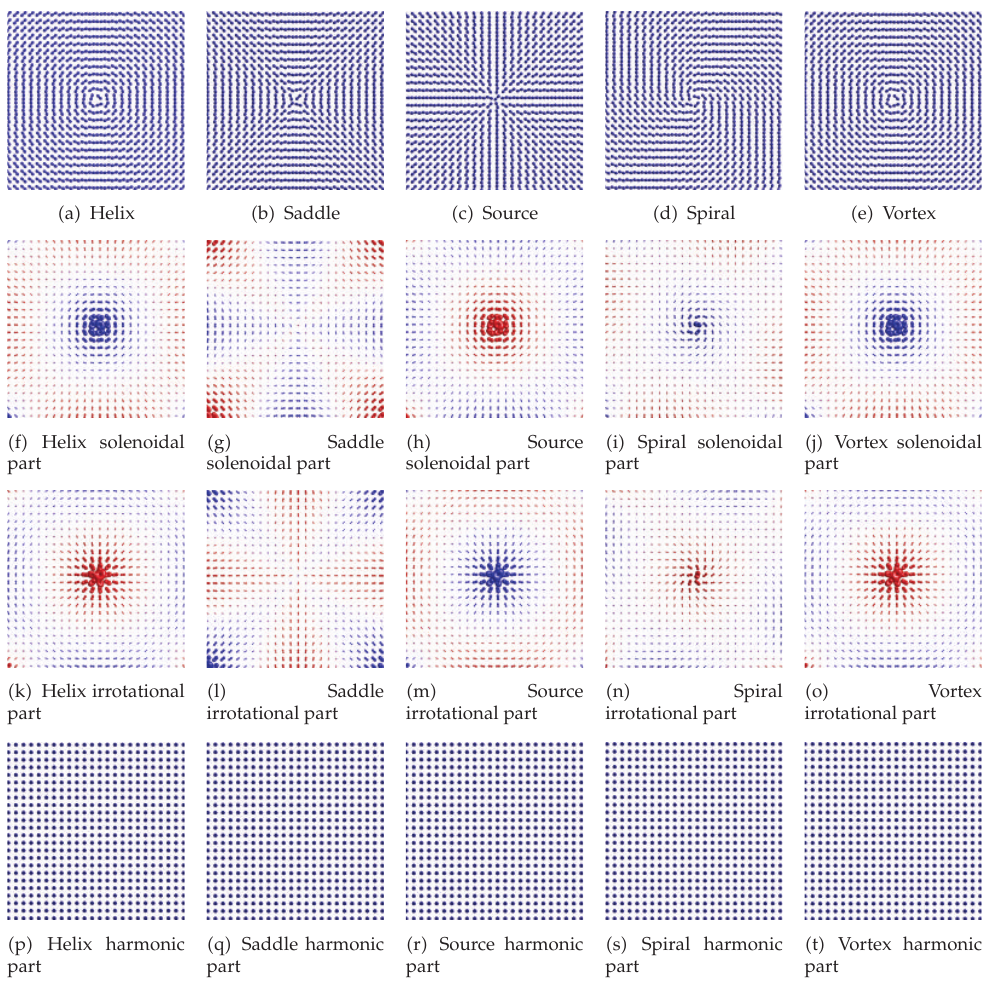
Figure 5: Helmholtz decomposition results for synthetic second-order tensor